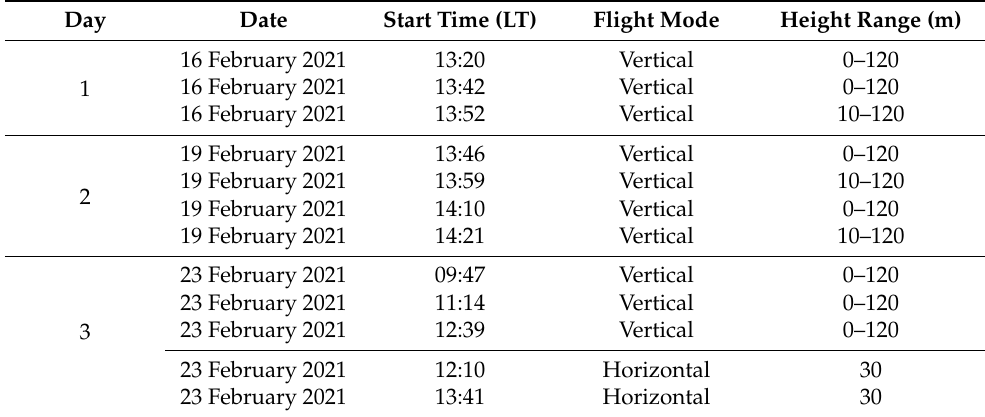
Table 2. Time schedule of the flights during the measurement